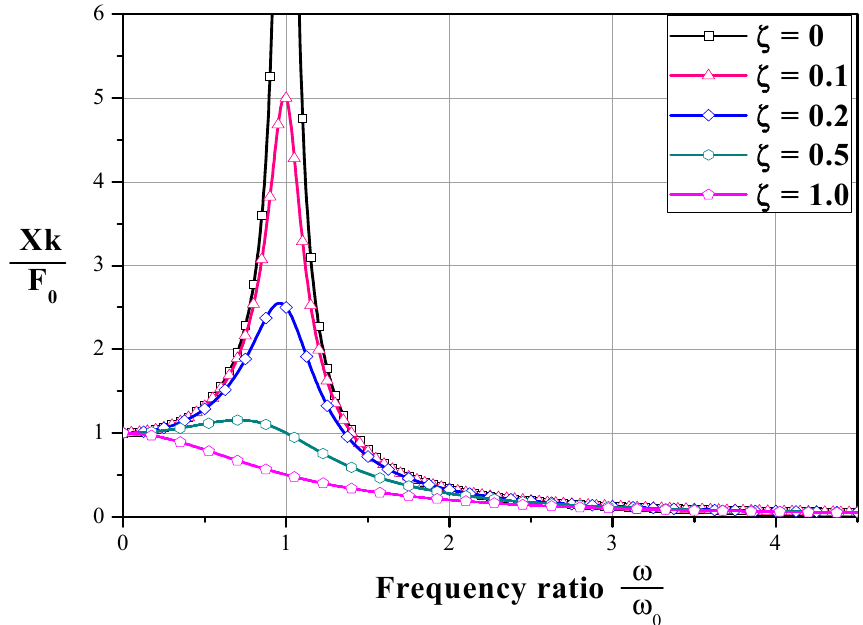
Figure 13. Nondimensional values of amplitude depending on damping factors.